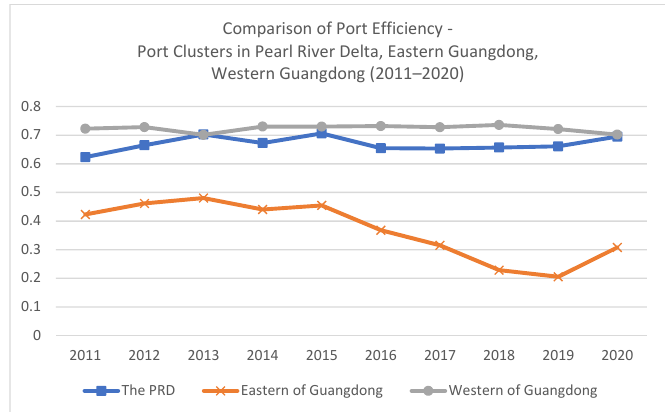
Figure 3. Port efficiency of three port clusters.